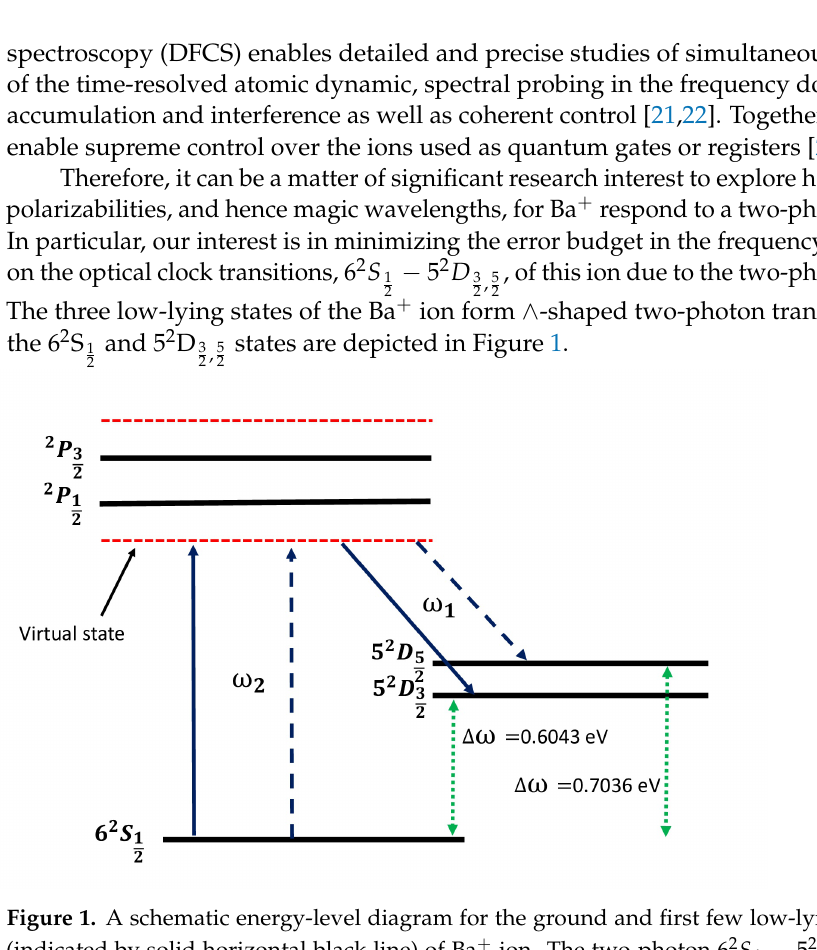
− 5 2 D (indicated by 3 2 2